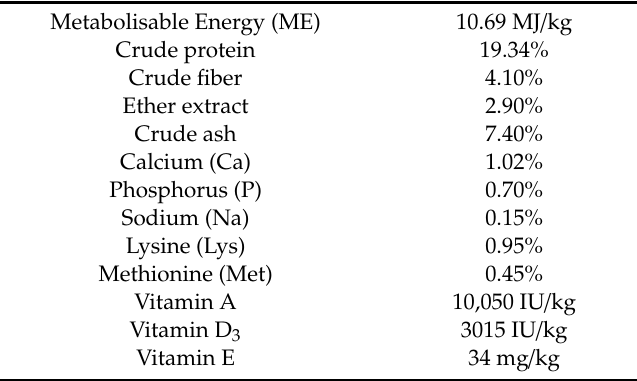
Table 1. Nutrient content of the broiler grower complete